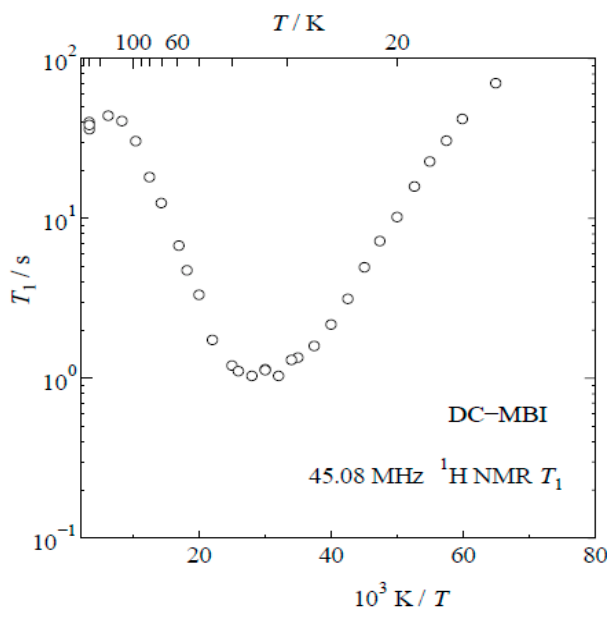
Figure 5. Temperature dependence of 1 H NMR spin-lattice relaxation time T 1 of DC-MBI.